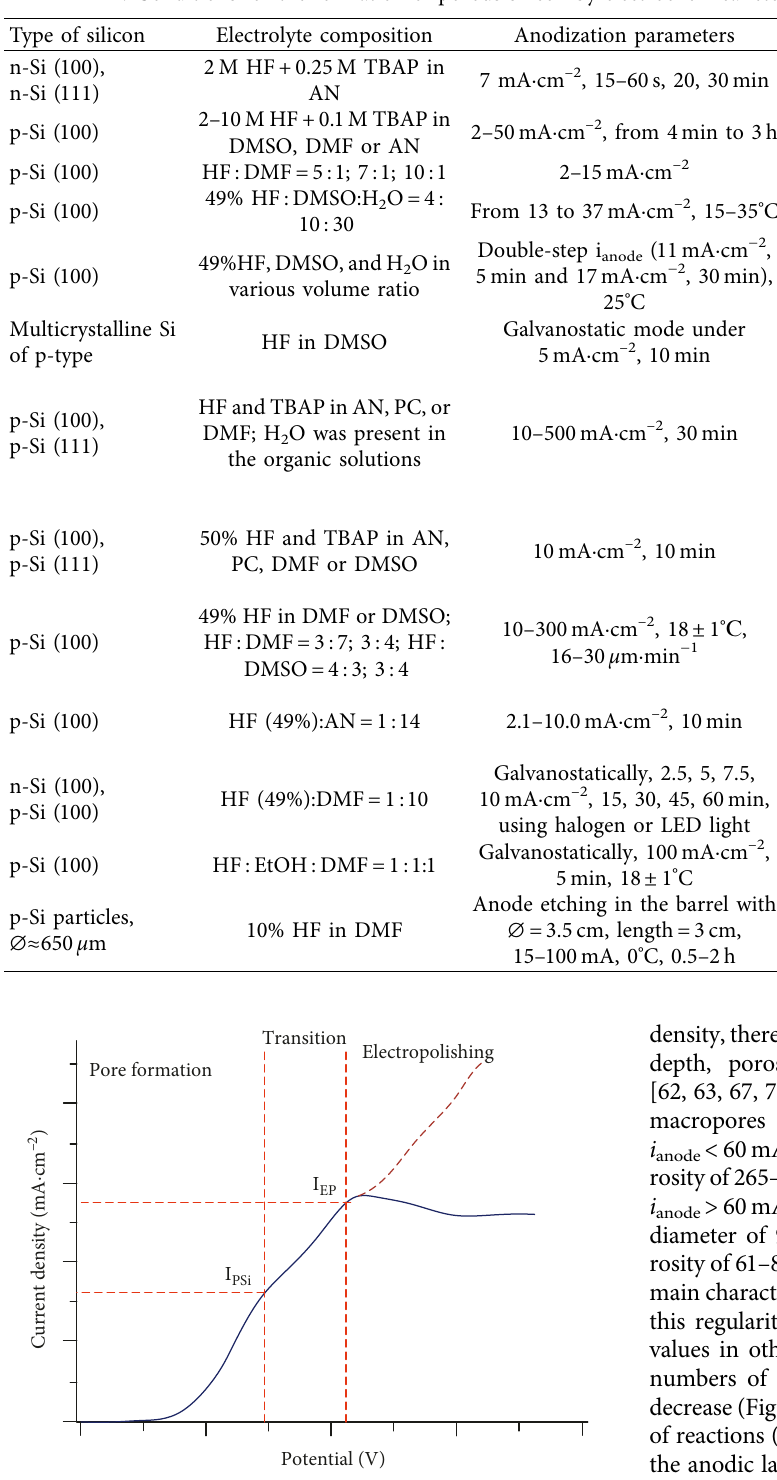
Figure 4: Stylized F - _ curve of silicon anodizing in HF